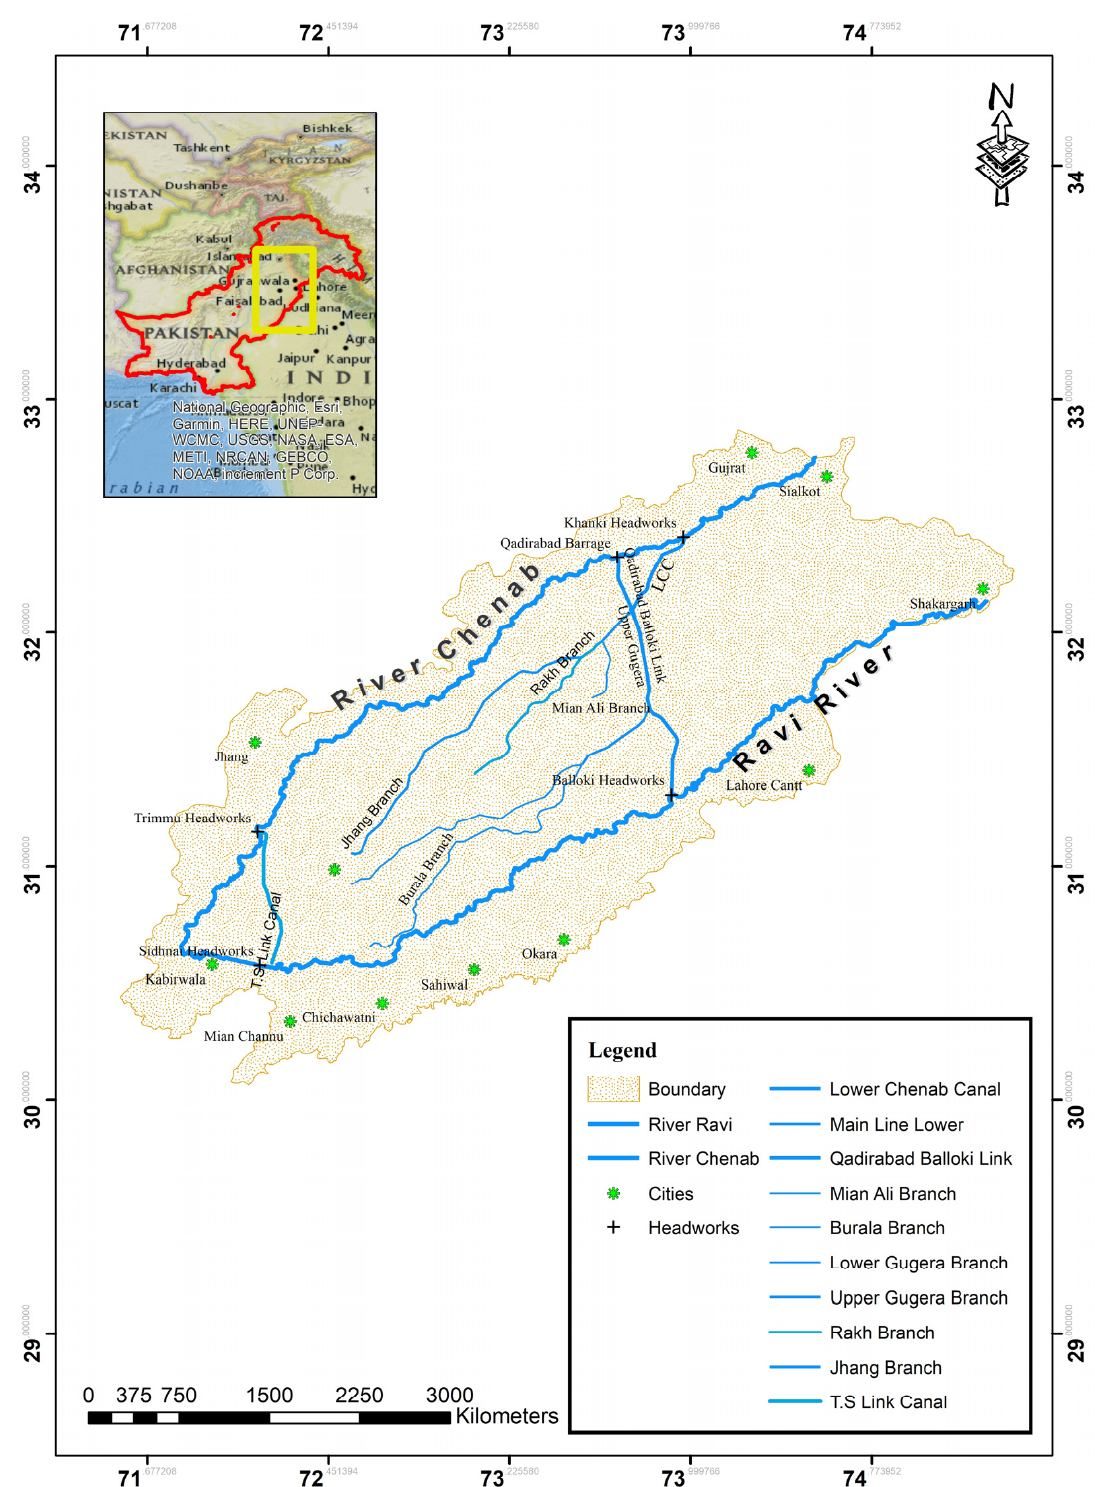
Figure 3. Location map with all rivers, canals, cities, and headworks. Data collected from various governmental and private departments includes the num- ber of tubewells, canal water supplies, crops grown, climatic parameters, and groundwater levels in various districts of the LCC area, which is tabulated in Table